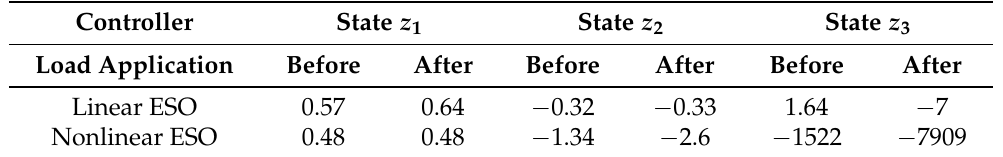
Table 2. Mean values of the states estimated by the linear and nonlinear ESO before and after the radial load